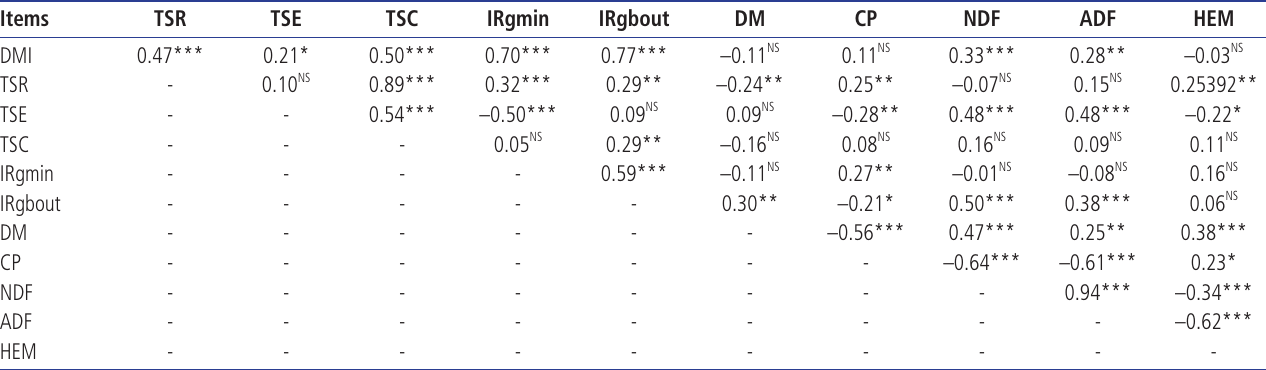
Table 11. Pearson correlation of feed attributes and feeding behaviour parameters for all experimental data 1)